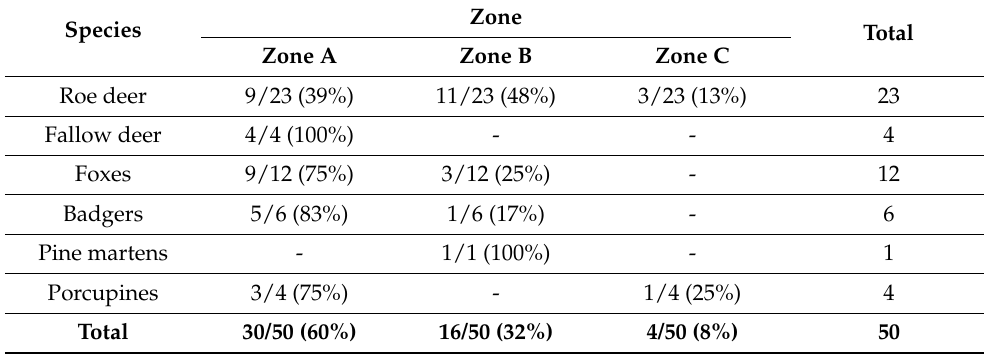
Table 3. Animal distribution in the three-rescue zones.